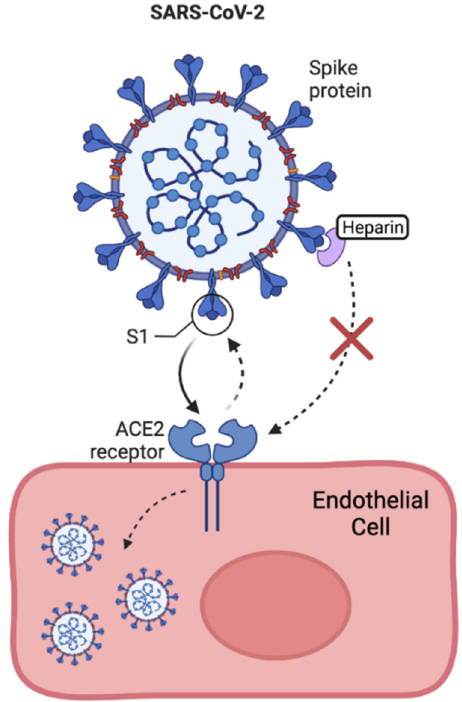
removal of cell surface HS with heparin lyases dramatically disrupts the binding of the S-